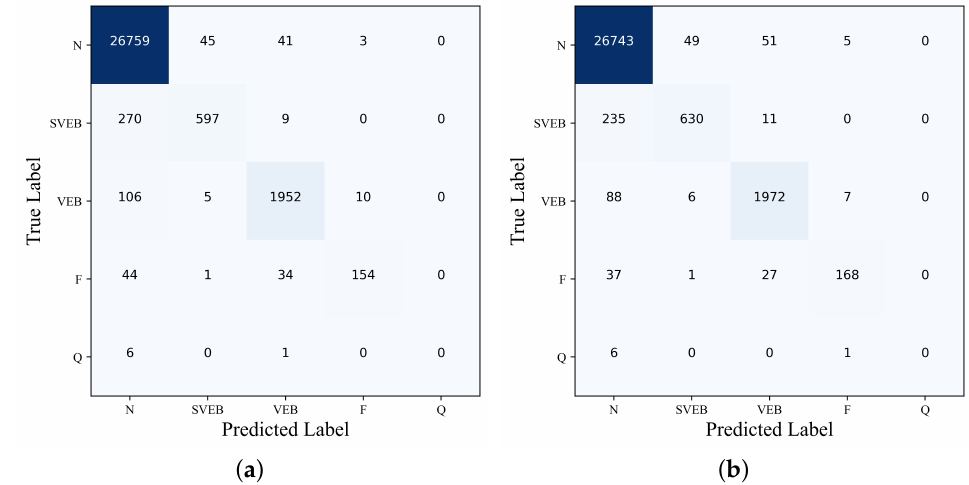
Figure 9. The confusion matrix heatmaps of heartbeat classification: ( a ) confusion matrix for the original SNN-based model; ( b ) confusion matrix for the SNN-based model integrated with the